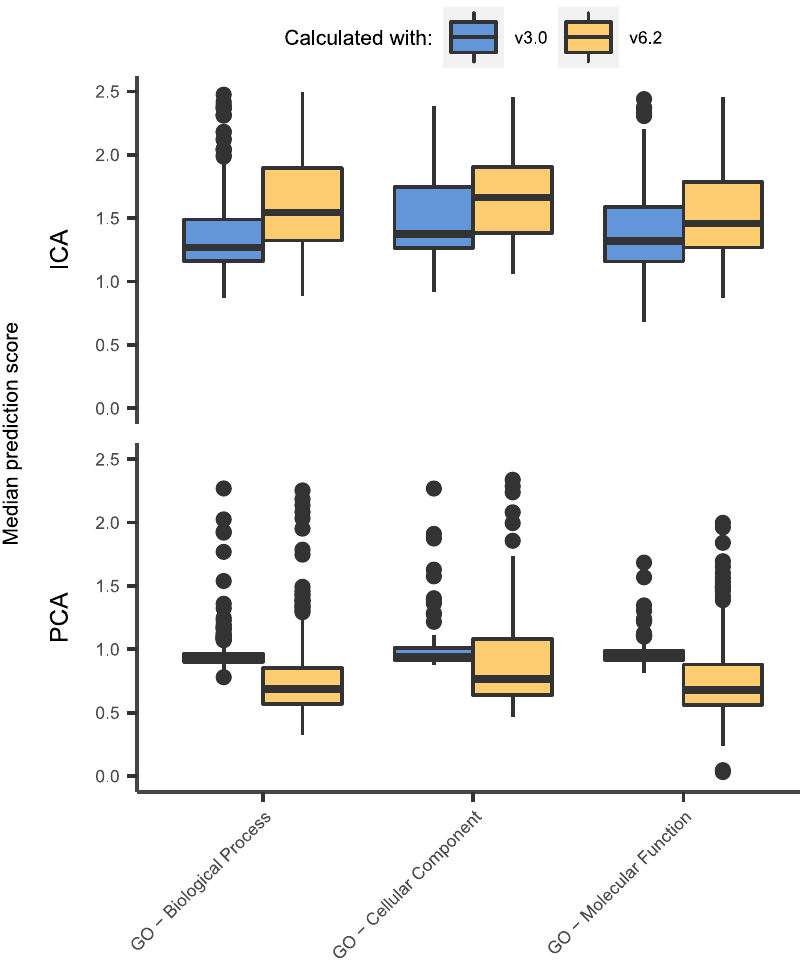
Fig. 3 ICA-TCs outperform PCA-TCs in predicting future gene set memberships. The predictive power of the PCA-TC- and ICA-TC-based GBA prediction strategies was further evaluated by generating predictions using a previous version of three Gene Ontology gene set collections (Molecular Signatures Database C5 v3.0). Boxplots show the prediction scores for every gene set using only genes that were added to the gene set between v3.0 (blue) and v6.2 (yellow). Prediction scores of this subset of genes degrade when using the newer version of the gene set (area under the curves (AUCs) calculated from two-sided Mann – Whitney U test ranging from 0.19 to 0.34) when generating predictions with the PCA-TC- but not when using the ICA- TC-based method (AUCs ranging from 0.65 to 0.71). Only gene sets for which new members were included are depicted. Hinges of boxes represent second and third quartiles and whiskers extend by half that interquartile range. Center of box corresponds to